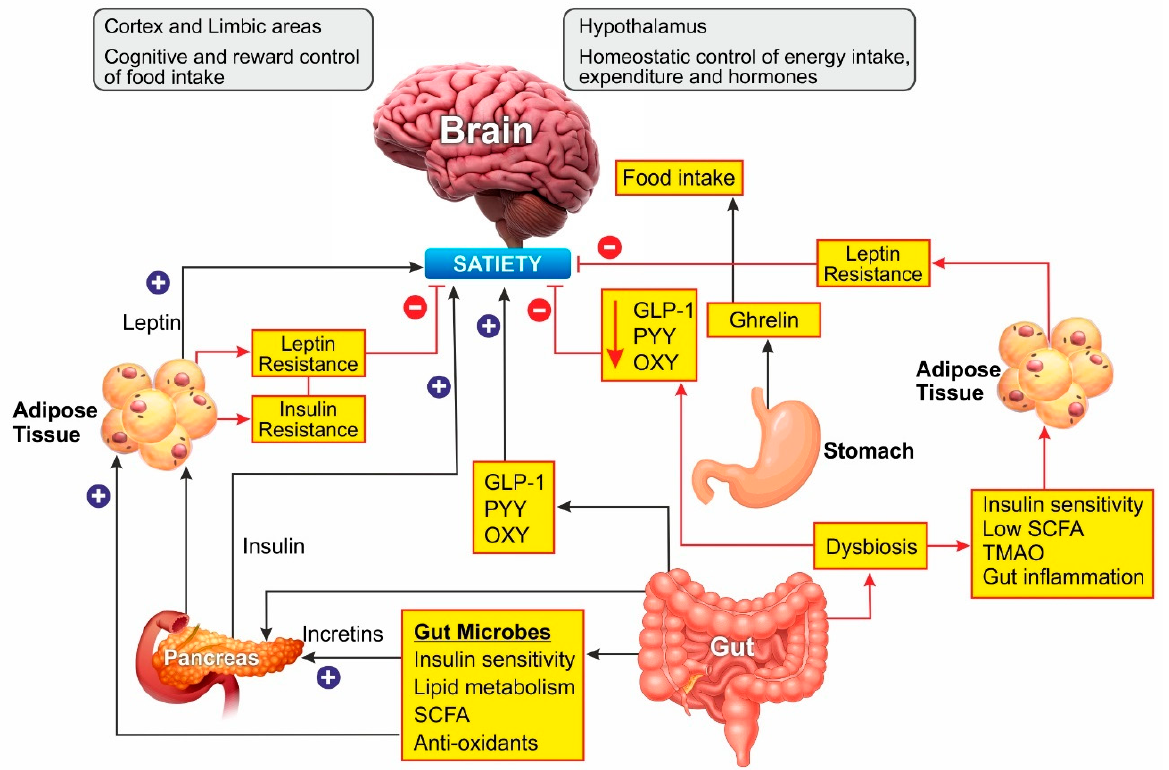
Figure 2. Schematic representation of Gut microbiome and hormonal control of obesity: Ghrelin, produced in the stomach, is a potent stimulator of appetite in the brain. Insulin from the pancreas and leptin from adipose tissue act on the brain to induce satiety. Gut-derived peptides such as GLP-1 augment insulin release from the pancreas. The gut microbiome balances energy homeostasis by releasing short-chain fatty acids with numerous benefits. Dysbiosis of the gut decreases the peptide hormone and increases gut inflammation, which can induce insulin and leptin resistance preventing satiety. In the brain, the hypothalamus region controls energy homeostasis while the cortex and limbal areas are responsible for cognitive reward control of food intake. CCK, cholecystokinin; GLP-1, glucagon-like peptide–1; OXY, oxyntomodulin; PYY, peptide YY; SCFA, short-chain fatty acids. Blue lines represent positive stimulation to control fat storage while red lines represent the causes of obesity.